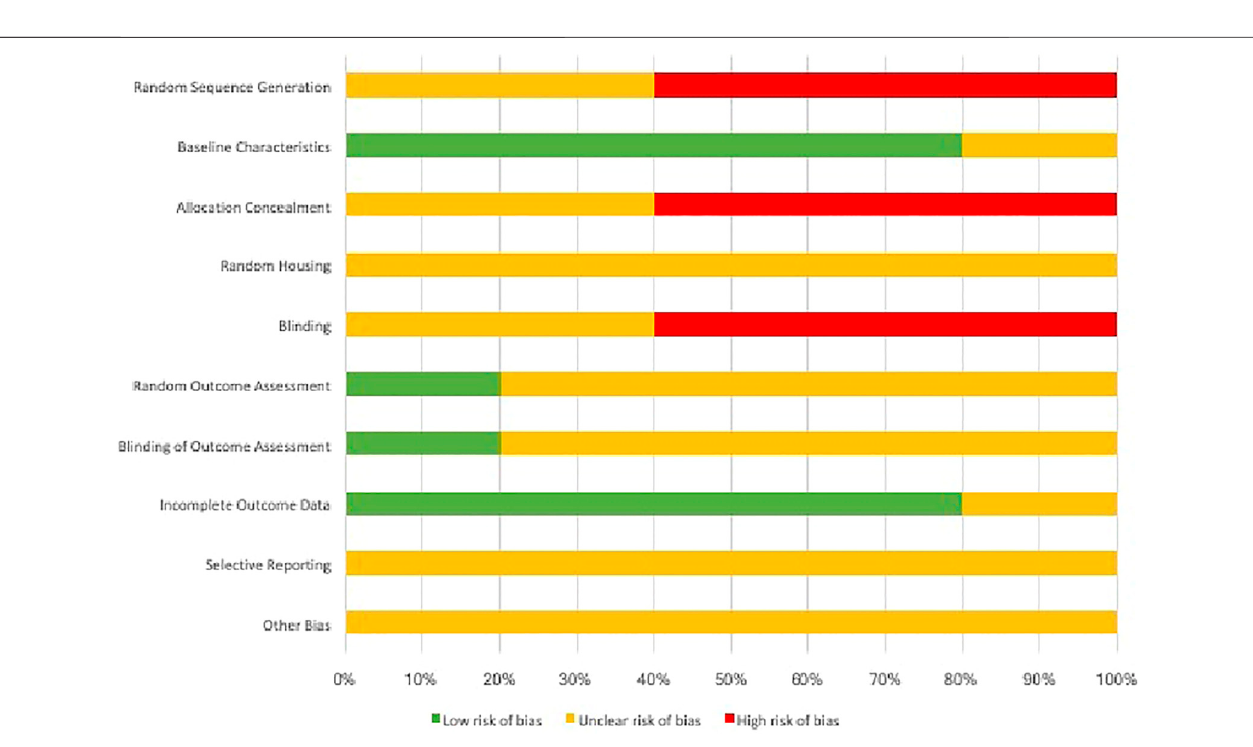
Frontiers in Materials |